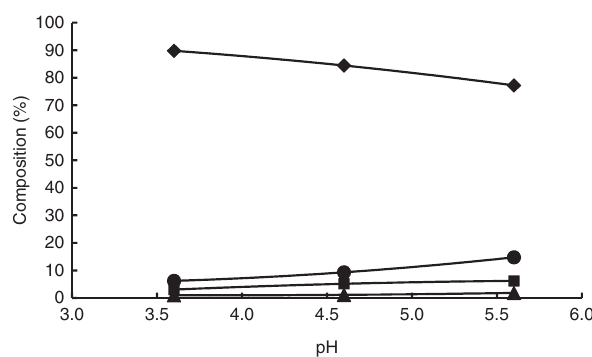
Figure 2 Effect of pH on the hydrogenation of cinnamaldehyde with [RuH(OAc)( m tppms) ] catalyst.  cinnamaldehyde, ■ 3-phenyl- 3 2-propanal,  3-phenyl-2-propan-1-ol, ● 3-phenyl-2-propen-1-ol. Conditions: 0.01 mmol catalyst, 0.8 mmol cinnamaldehyde, 3 ml acetate buffer, 80 ° C, 2 h, P(H ) = 7 bar. 2